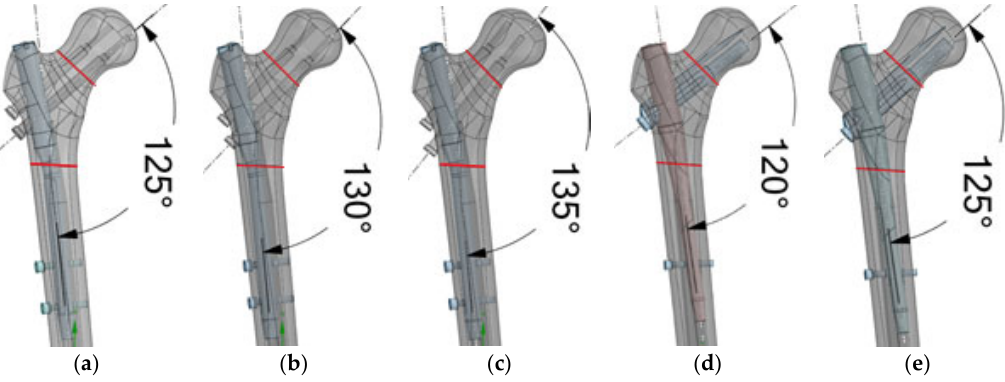
Figure 7. Modified CAD models of a broken femur with nails—( a – c ) Medin; ( d , e ) Tantum. In order to attain an acceptable level of simplification in the FEM simulation, the CAD models were modified appropriately (see Figure 8). This reduces computing time but has no substantial impact on the analytical results. The screws were modelled as pin ‐ type structures; the screw thread was replaced by a cylindrical portion with the same diameter as the minor thread diameter (on the side of safety). The threads of the fixation screws were modified to approximately the mean diameter of the screw threads (representing an acceptable simplification), except at the point of contact with the nail, where the major thread diameter was retained (for accurate representation of the contact). The screw heads were modified to cylindrical volumes in order to simplify the simulation (this does not affect the results).